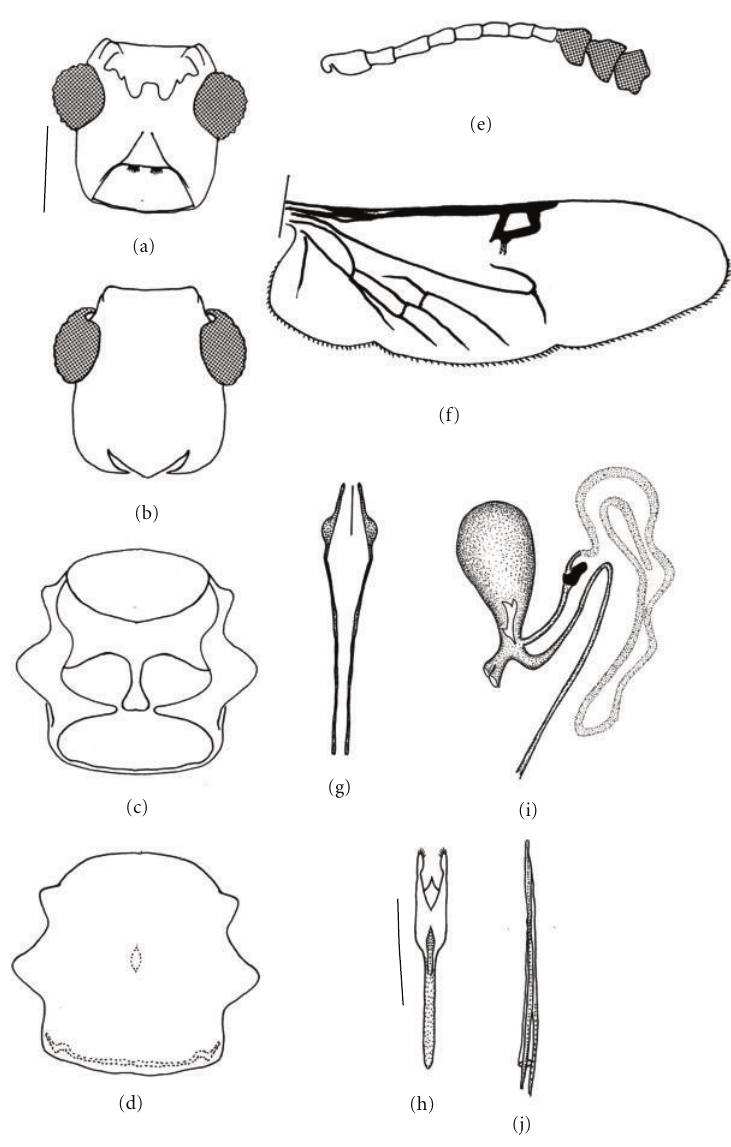
Figure 13: Various organs of Pylus fatuus . (a, b) Head ((a) ventral, (b) dorsal). (c, d) Pronotum ((c) ventral, (d) dorsal). (e) Antenna. (f) Metathoracic wing. (g) Spiculum. (h) Tegmen. (i) Female mesodermal reproductive organs. (j)